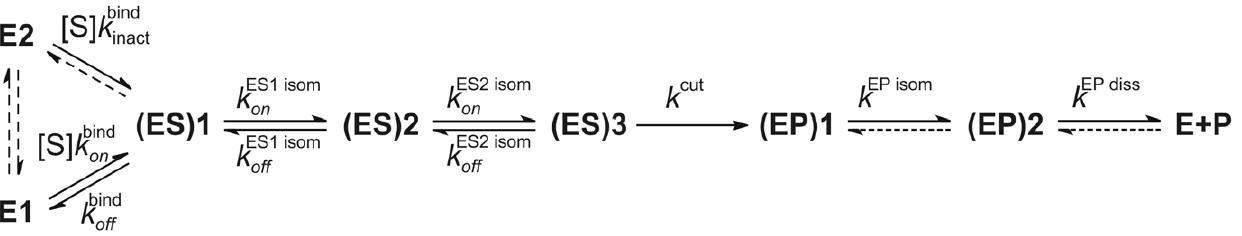
Figure 9. The kinetic scheme describing the interactions of APE1K98A with specific DHU-substrate during NIR.